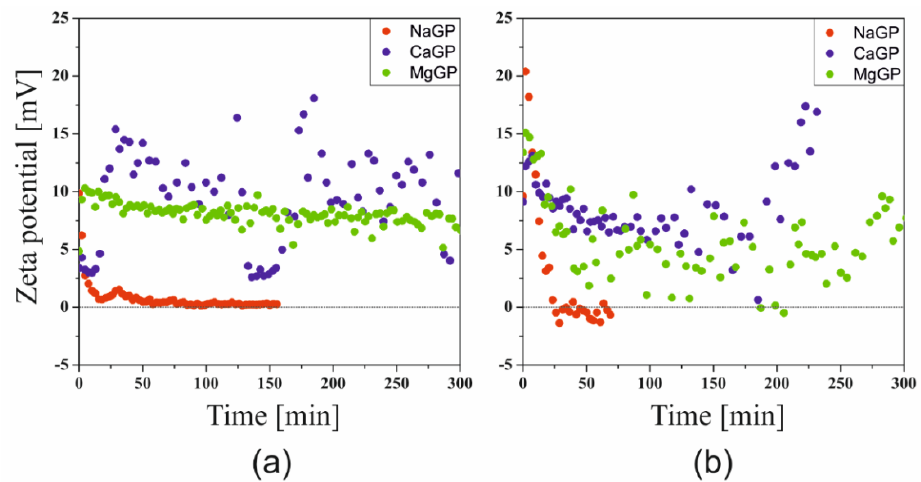
Figure 3. Kinetics of changes in the value of the Zeta potential of solutions of chlorides ( a ) and acetates ( b ) of crab chitosan.